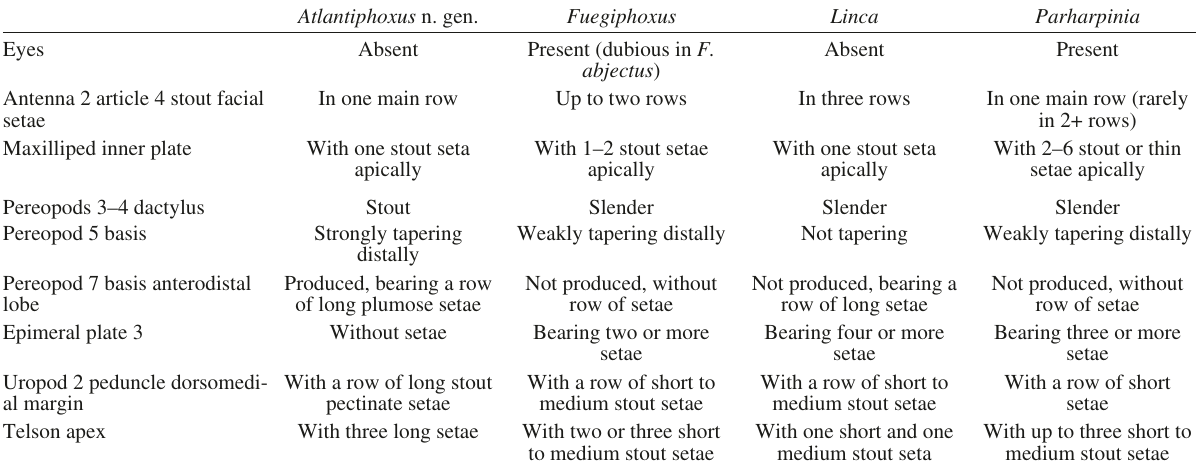
Table 1. – Diagnostic characters of Atlantiphoxus n. gen. and its closest genera. Atlantiphoxus n.